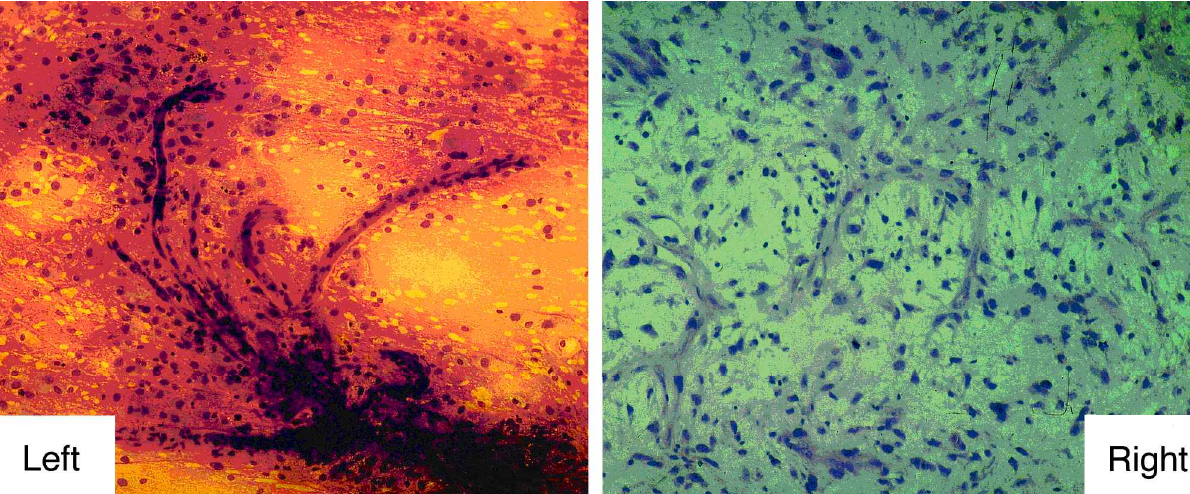
Fig. 2. Low-power view of a low-grade myxo® brosarcoma. Left: aspirate; right: part of the surgical specimen. The typical histopathological features are easily observed in the smear: myxoid background matrix, curvo-linear vessels and slight atypia . (MMG and HE 3 250).